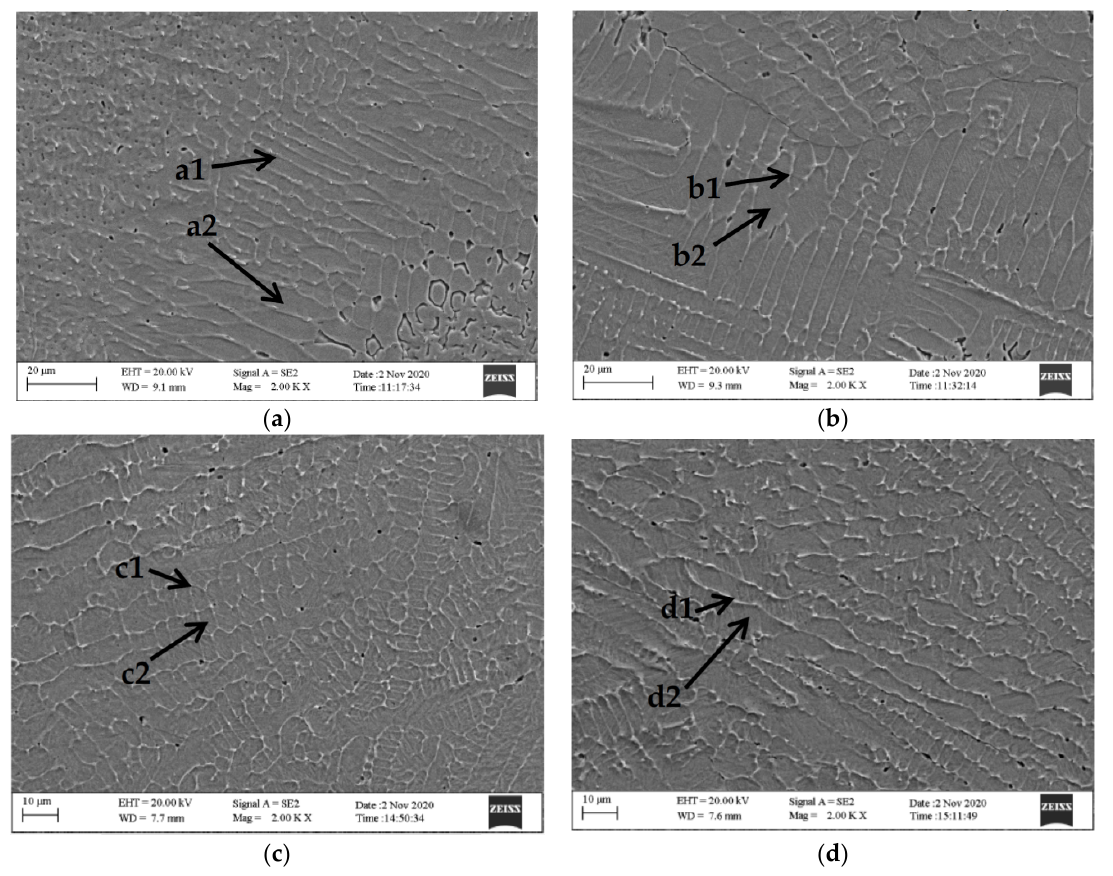
Figure 4. SEM images of cladding layers: ( a ) the cladding layer of AlCoCrFeNi(WC) 0 ; ( b ) the cladding layer of AlCoCrFeNi(WC) 0.1 ; ( c ) the cladding layer of AlCoCrFeNi(WC) 0.2 ; and ( d ) the cladding layer of AlCoCrFeNi(WC) 0.3